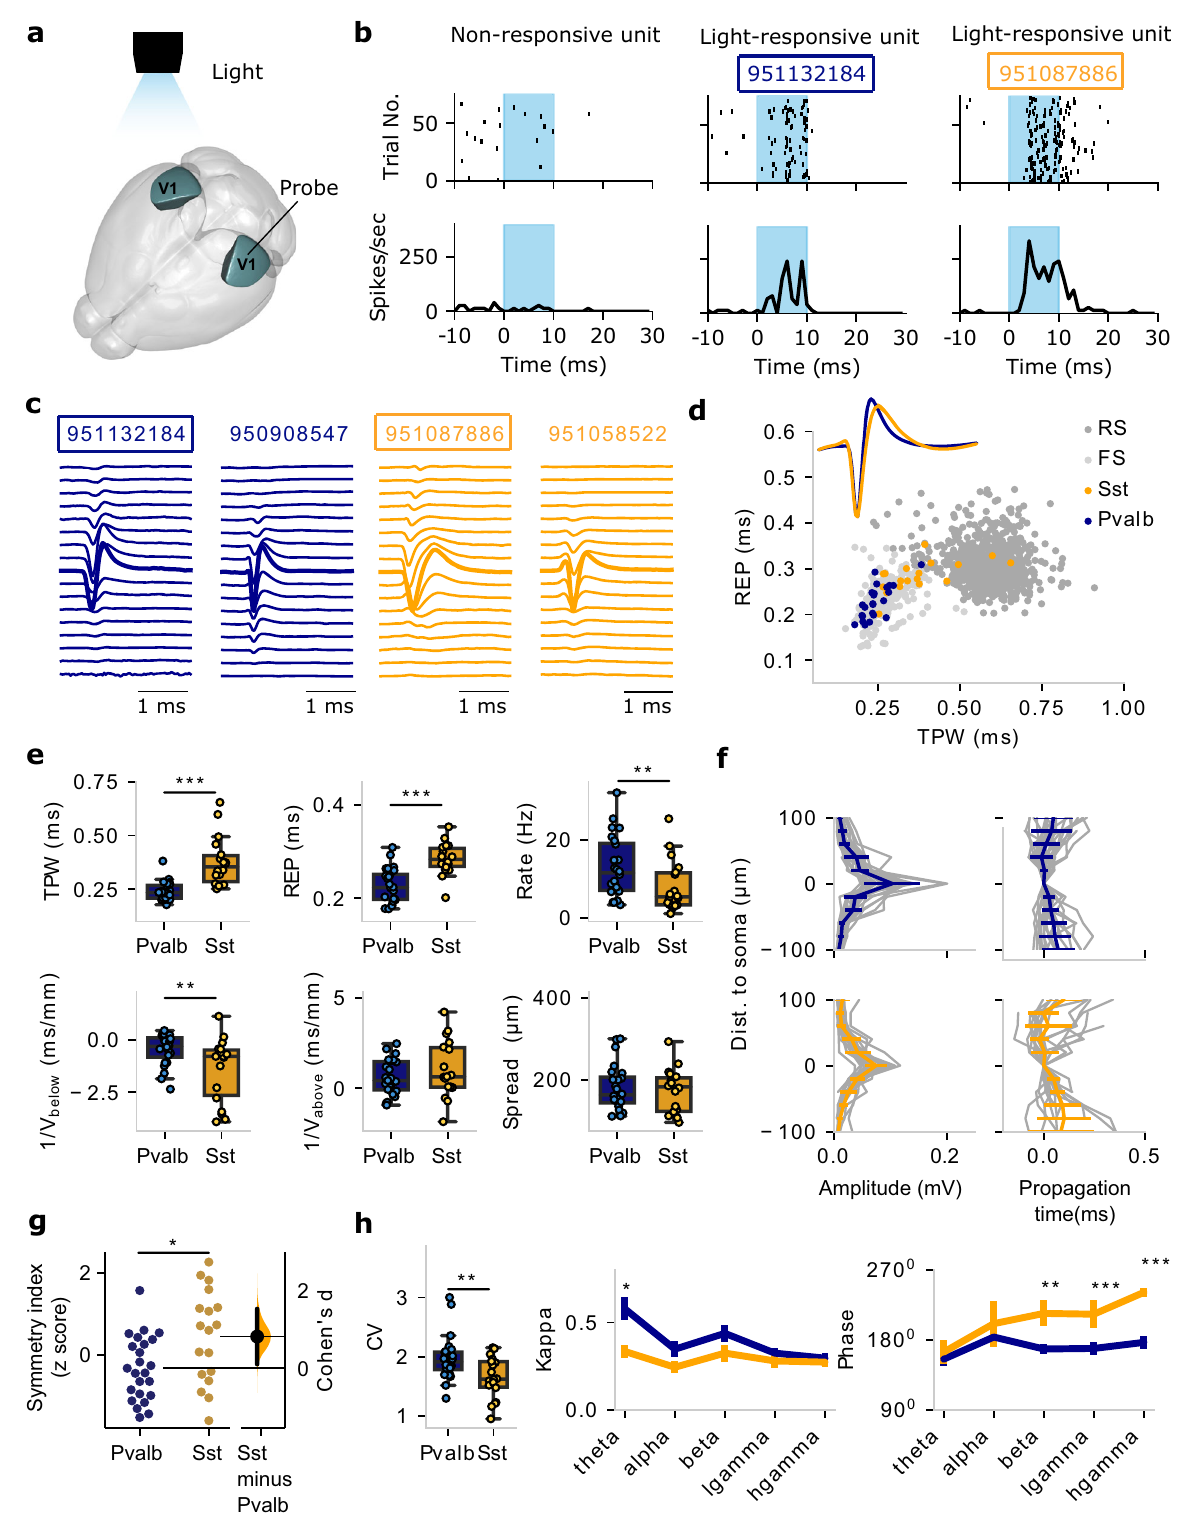
coupling pro fi le points to the existence of a cellular and functional organization along the depth